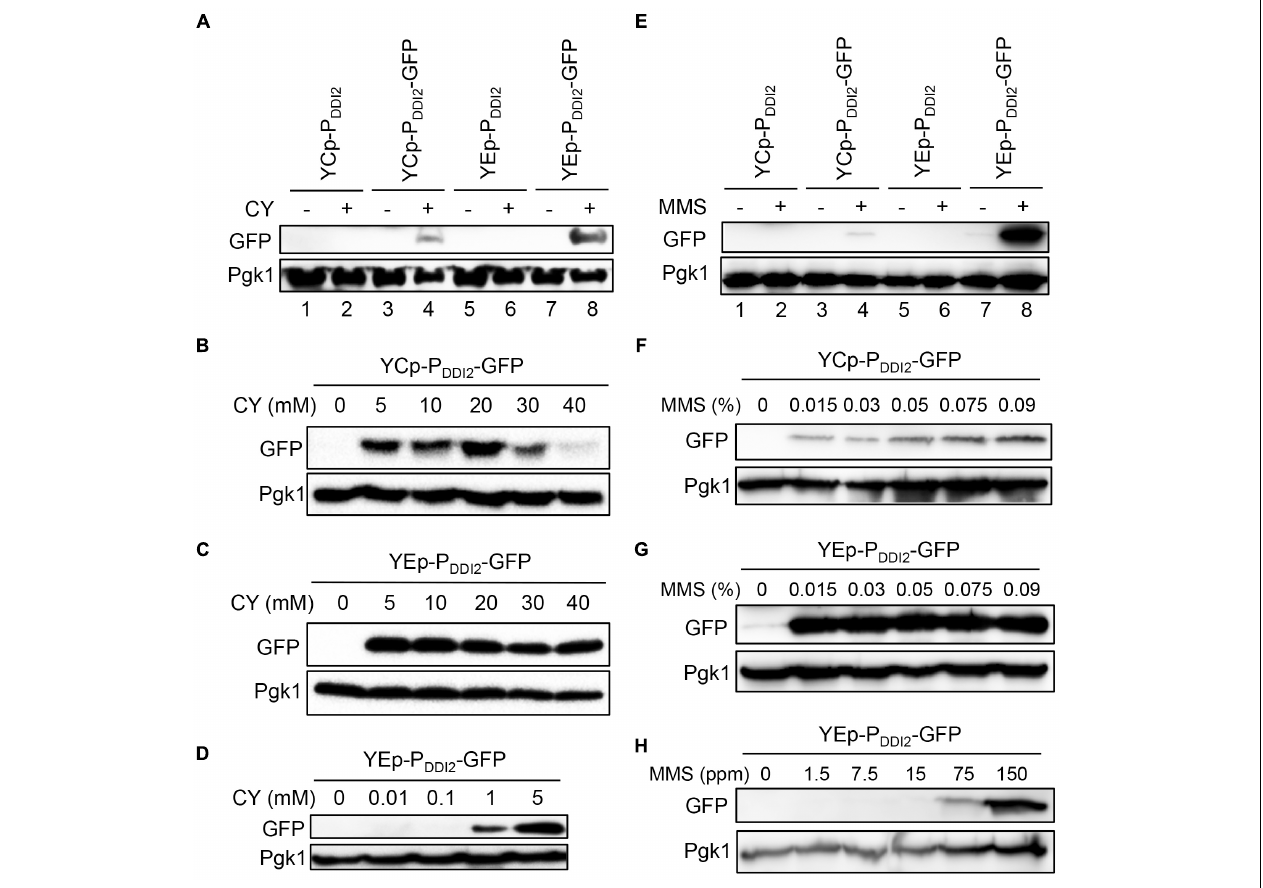
FIGURE 4 | Western blot analysis of P DDI2 -GFP gene products. (A) Cells harboring YCp- and YEp-based plasmids in response to 20 mM CY treatment. (B) Dose response of YCpU-P DDI2 − GFP-transformed cells in response to CY. (C) Response of YEpU-P DDI2 − GFP-transformed cells in response to high CY doses. (D) Response of YEpU-P DDI2 − GFP-transformed cells in response to low CY doses. (E) Cells harboring YCp- and YEp-based plasmids in response to 0.015% MMS treatment. (F) Dose response of YCpU-P DDI2 − GFP-transformed cells in response to MMS. (G) Response of YEpU-P DDI2 − GFP-transformed cells in response to high MMS doses. (H) Response of YEpU-P DDI2 − GFP-transformed cells in response to low MMS doses. The experimental protocol is described in Materials and